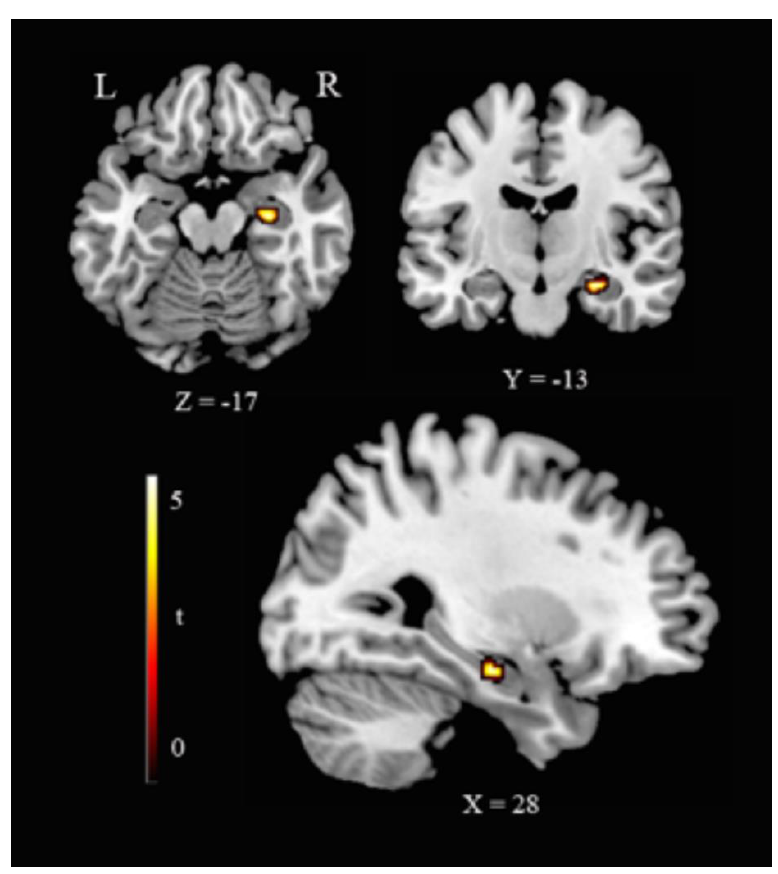
Figure 2. Hippocampal volume reduction in HC(WMH + ). Representative slices showing VBM ROI-based results as for the contrast HC(WMH − ) > HC(WMH + ). Legend: R, right; L, left; Coordinates are in Montreal Neurological Institute (MNI)